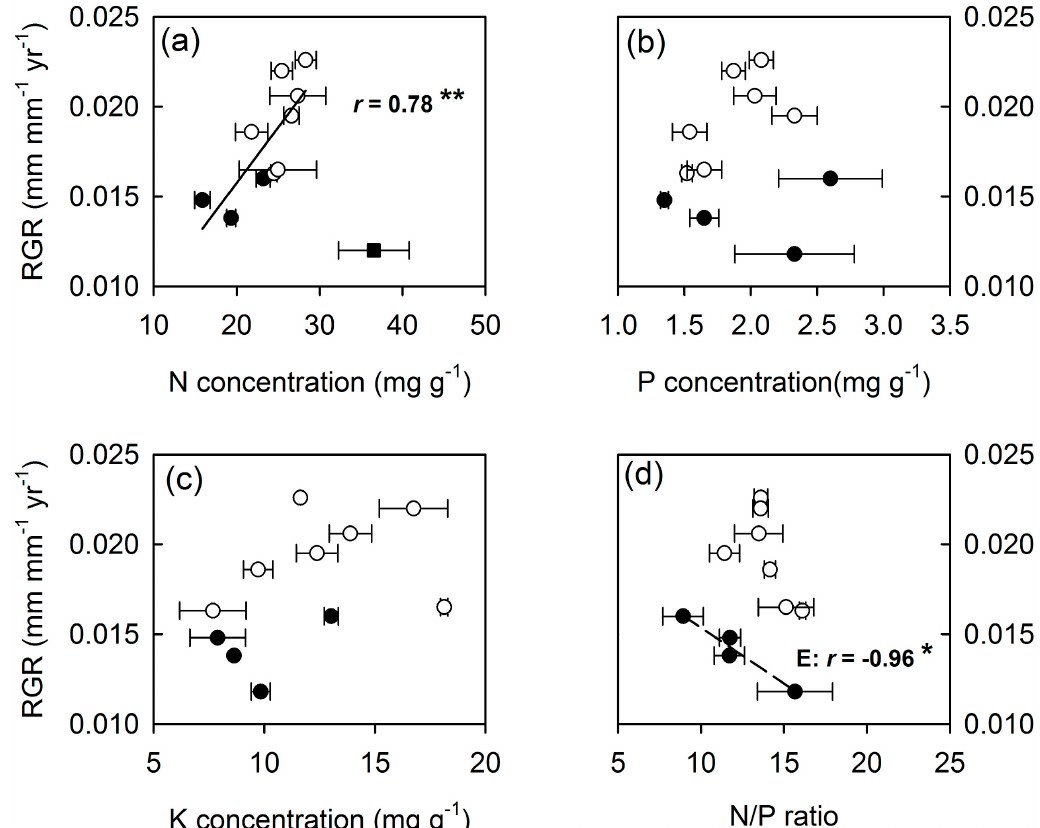
Figure 4. Relationships of relative growth rate (RGR) values with ( a ) N, ( b ) P, ( c ) K, and ( d ) N / P ratios across seven deciduous (open circle) and four evergreen (E, filled circle) lianas. Solid lines indicate significant correlations between RGR and N concentrations across ten liana species, excluding the legume liana species ( Callerya dielsiana (Harms) P. K. Loc ex Z. Wei & Pedley), which is an outlier (black square). The horizontal error bars indicate the standard error of leaf nutrients. Note: * p < 0.05; ** p < 0.01.